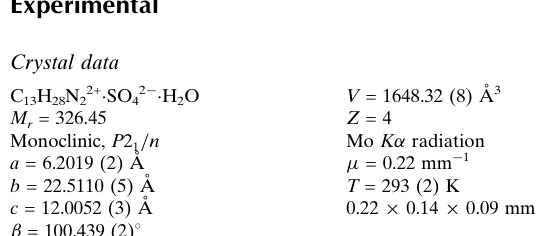
Experimental Crystal data